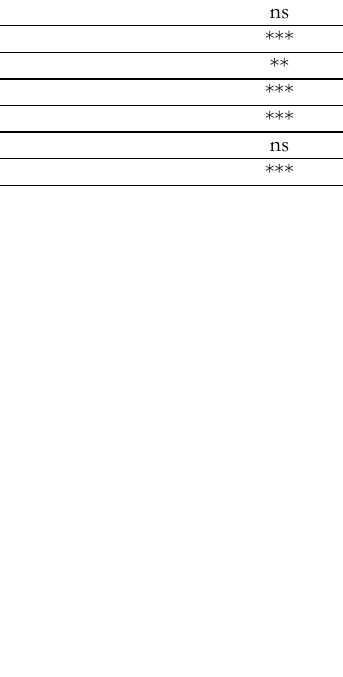
Table 5. Structural Analysis Results Hypothesis Relationship